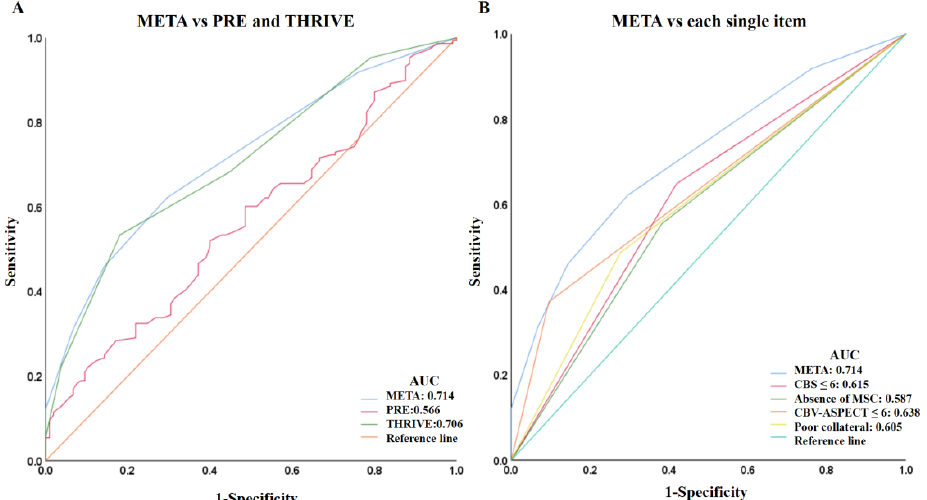
Figure 1. ROC analysis for poor outcome. ( A ), Discriminative power (area under the curve (AUC)) of META, PRE, and THRIVE for poor outcome; ( B ), AUC of META and each single item of META score for poor outcome.